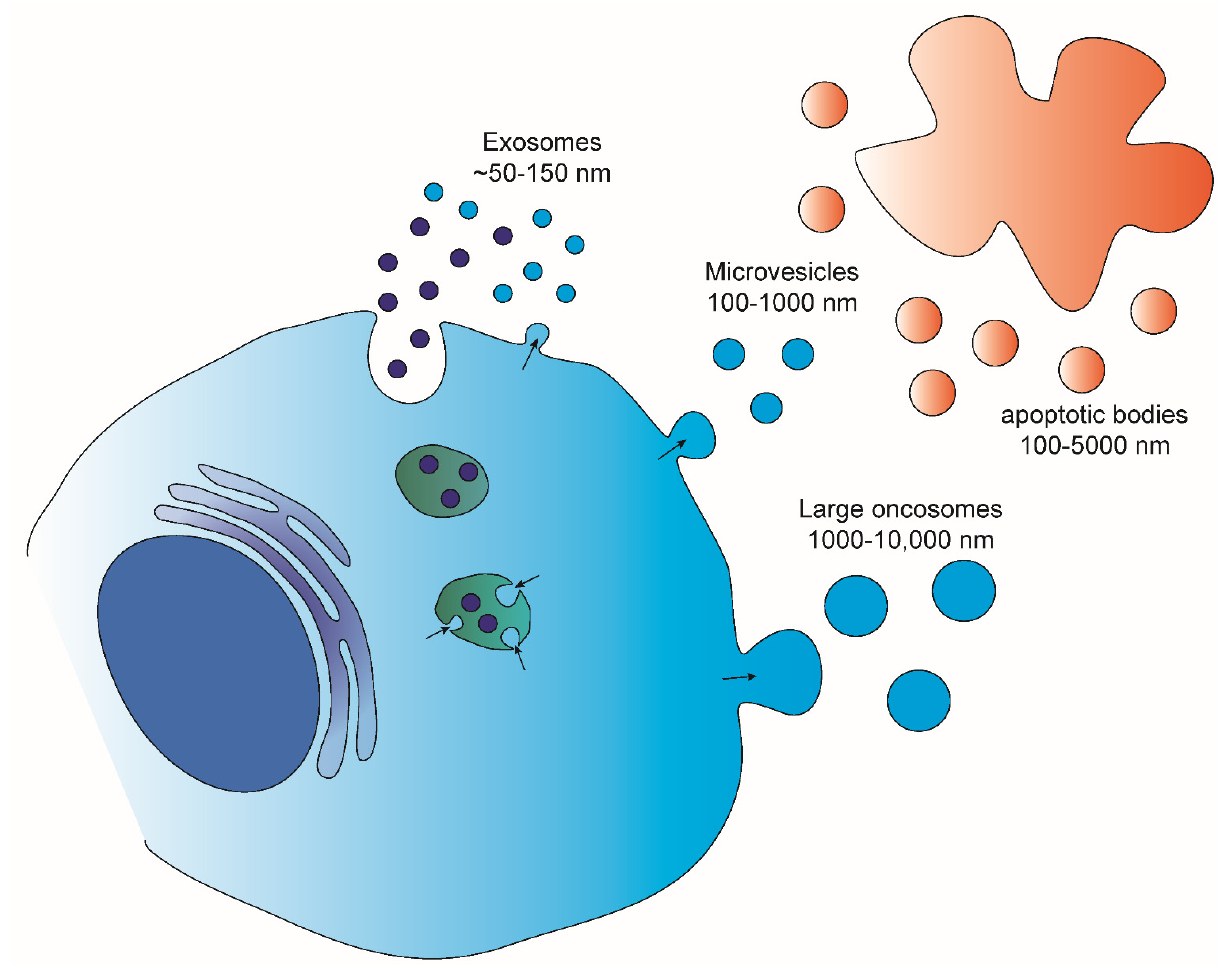
Figure 1. Types, sizes and biogenesis of the main types of extracellular vesicles. Exosomes are mainly derived from the fusion of the multivesicular bodies with the plasma membrane and are between 50–150 nm in size. Apoptotic bodies are bigger (100–5000 nm) and are formed by membrane budding of apoptotic cells. Finally, micro-vesicles (100–1000 nm) and large oncosomes (1000–10,000 nm) are released via the budding of the plasma membrane.